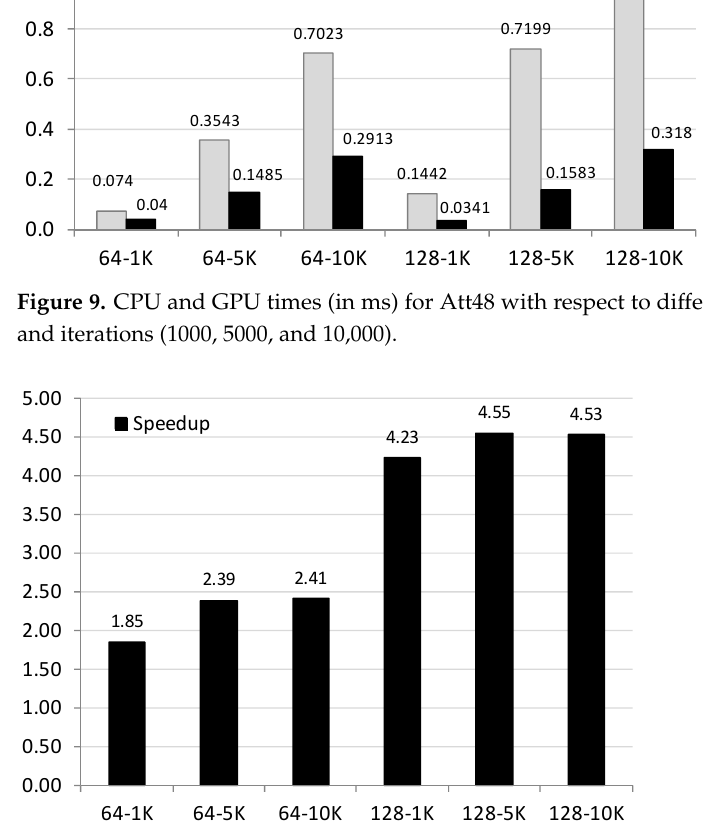
Figure 10. Speedup when comparing CPU and GPU times for Att48 with respect to different pop- ulations (64 and 128) and iterations (1000, 5000, and 10,000).